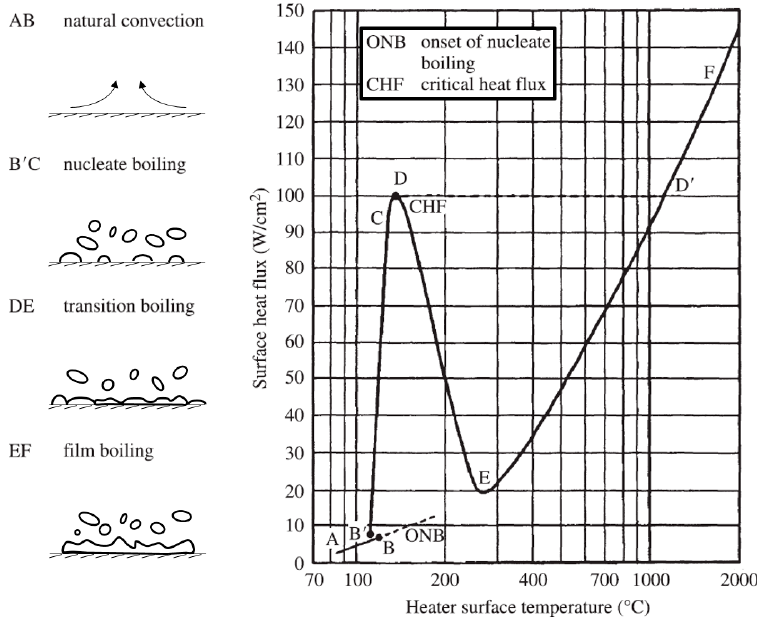
Figure 7. Heat flux (Y-axis) as a function of heater surface temperature (X-axis) showing the different boiling regimes for a horizontal plate submerged in a liquid (adapted from Reference [67]).